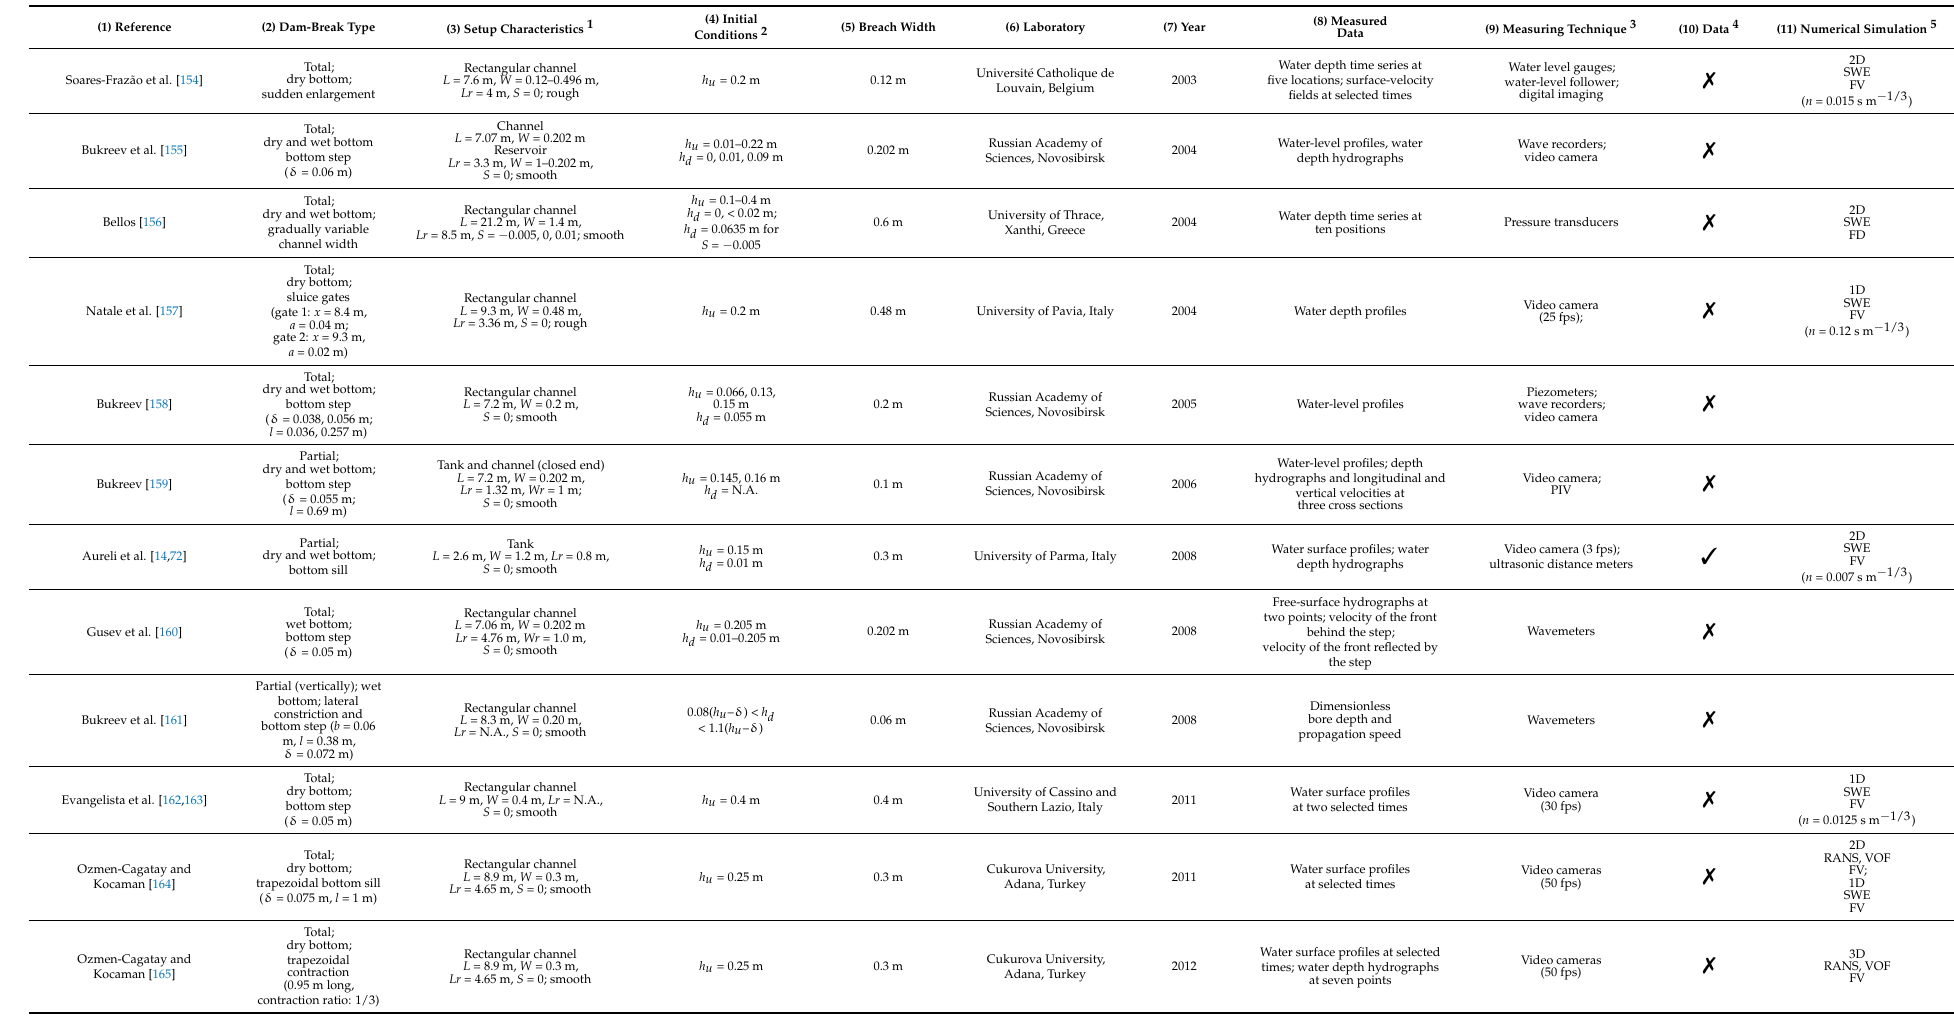
Table 1. Basic experimental investigations of fundamental dam-break wave physical characteristics.